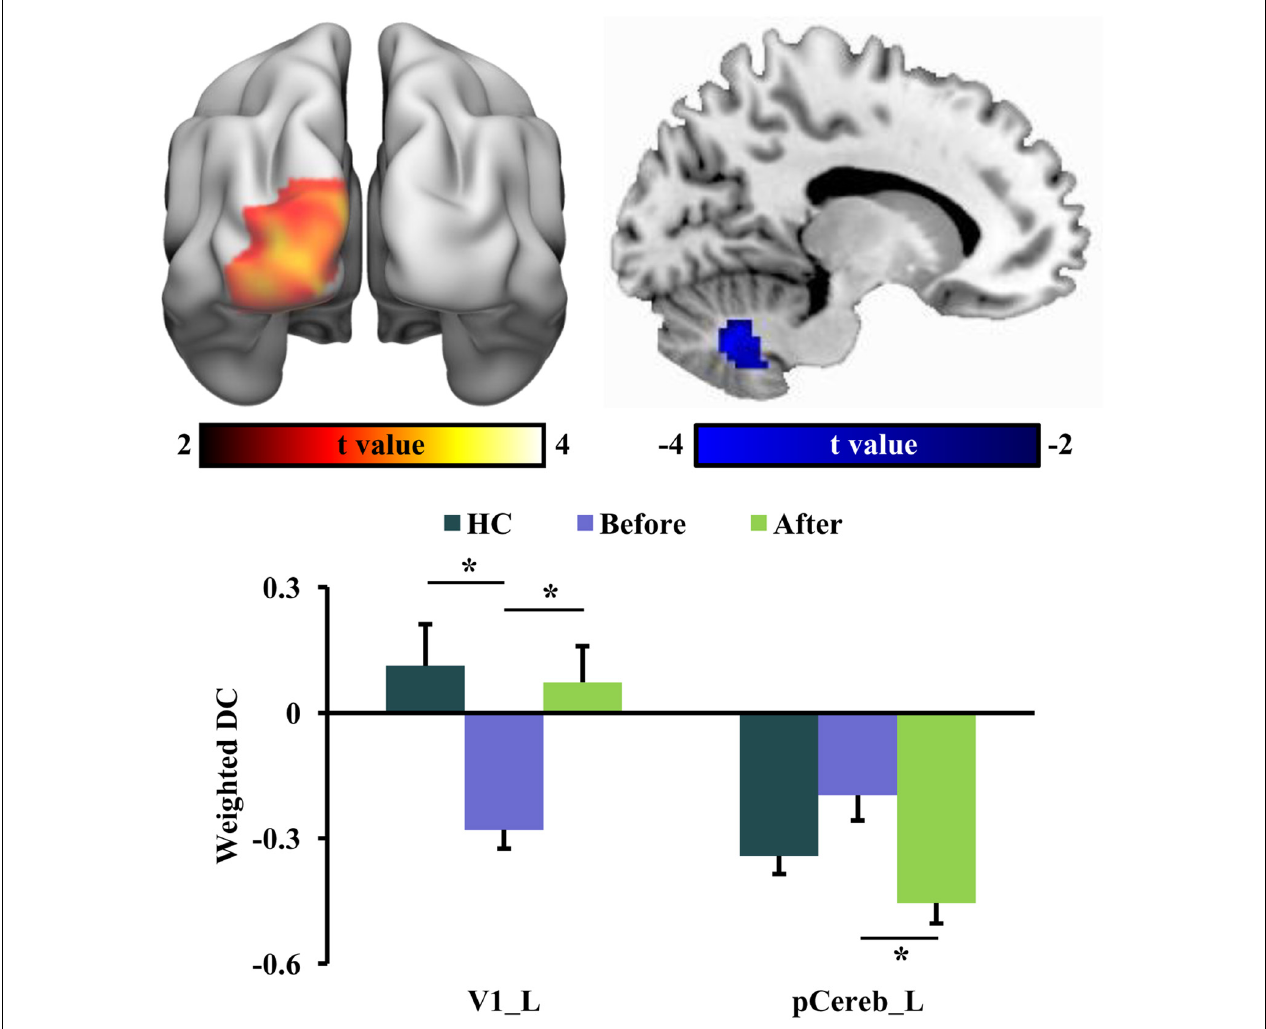
FIGURE 3 | Changed weighted degree centrality (DC) in restless leg symptom (RLS) patients after transcutaneous spinal cord direct current stimulation (tsDCS) treatment. Paired t -test found significantly decreased weighted DC in posterior cerebellum (pCereb) and significantly increased weighted DC in primary visual cortex (V1) in RLS patients after tsDCS compared to that before tsDCS. Regional mean weighted DC values in pCereb and V1 were calculated in healthy controls (HC) and RLS patients before and after tsDCS. Two-sample t -tests only found significantly increased weighted DC of V1 in HC compared to RLS patients before tsDCS. No other significant differences in weighted DC between HC and RLS patients before or after tsDCS were found. * p <